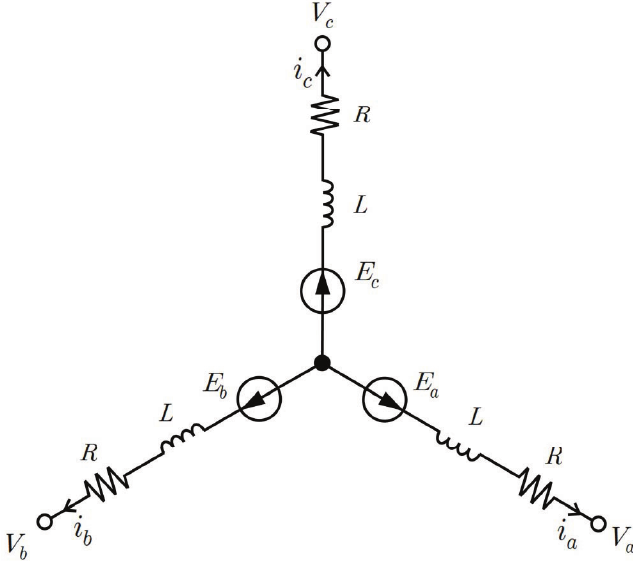
Figure 1. 3 Phase equivalent circuit of